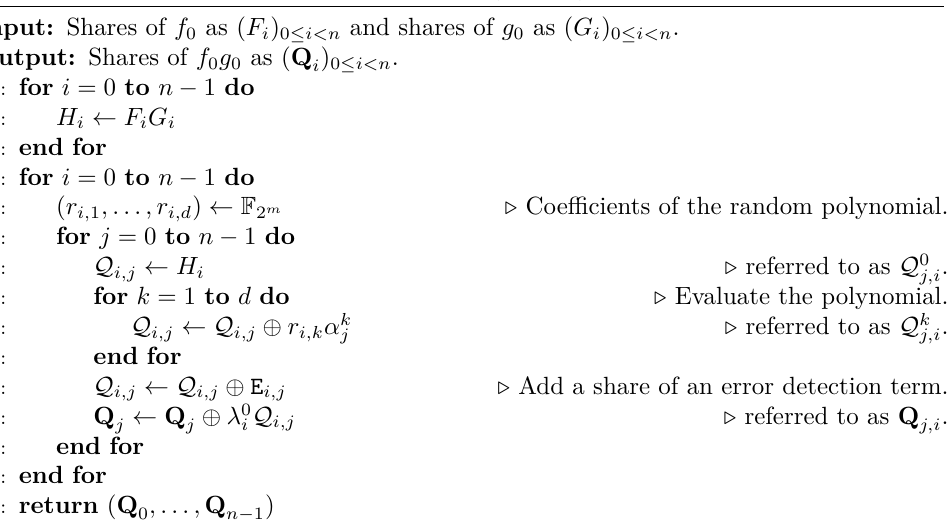
Algorithm 1 Error Preserving Multiplication ( EPMult